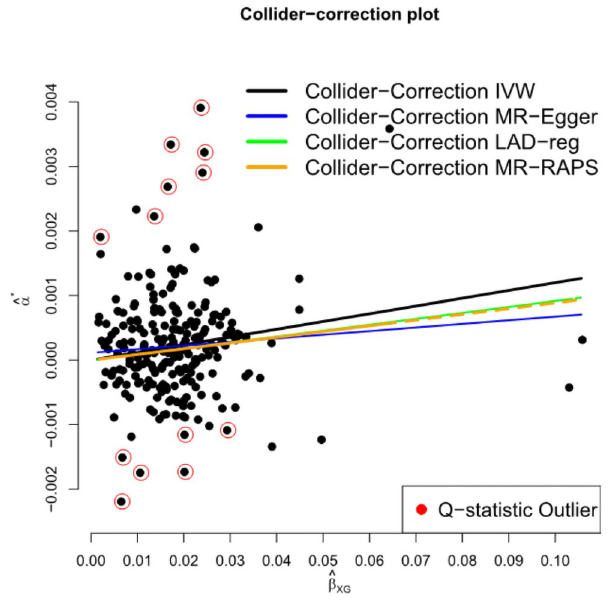
Fig 15. Collider biased SNP outcome associations, ^ a � were genome-wide significant using 23andMe and UKB